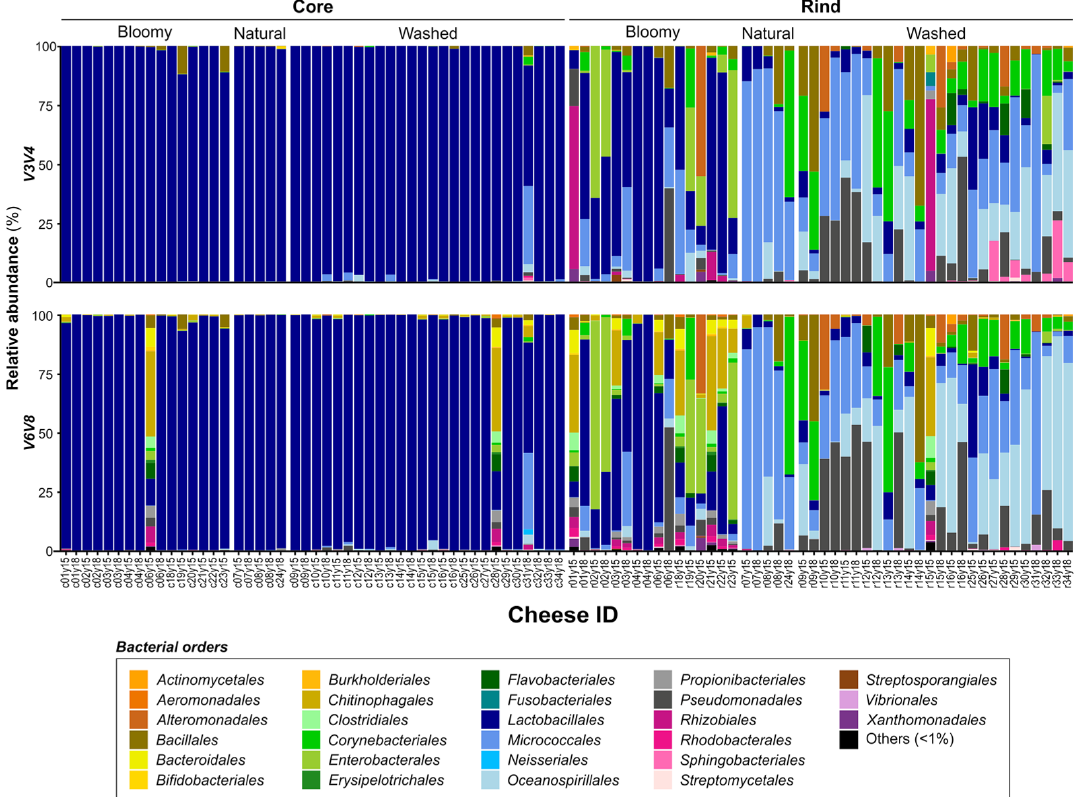
Figure 1. Comparative distribution of the most abundant bacteria in cheese ecosystems. Each column shows the relative abundance of the bacterial microbiota (16S rDNA), representing over 1% of the average abundance (order <1% are combined and shown in black). Vertical sections show different 16S DNA targets: the top row shows V3–V4 data, and the bottom row shows V6–V8 data. Horizontal sections show different parts of the cheese according to the rind type (bloomy, natural or washed): the left row shows cheese core data, and the right row shows cheese rind data. The last number of the cheese ID refers to the year of production (2015 or 2018) for the 32 cheese varieties.